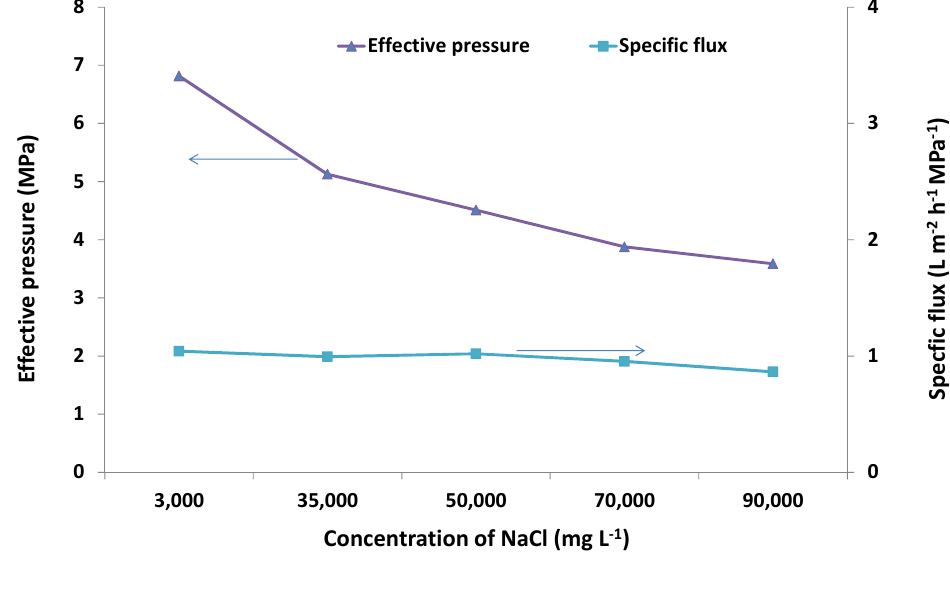
Figure 3. Effective pressure and specific flux on the zeolite membrane for the feed solutions with different NaCl concentrations (TDS 3000 to 90,000 mg·L − 1 ) at an applied pressure of 7 MPa (gauge) and 21